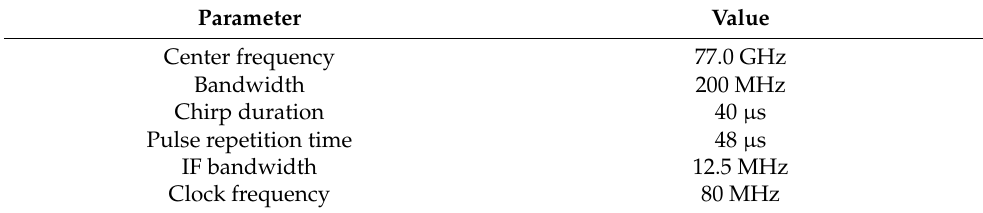
Table 6. Parameters of the test